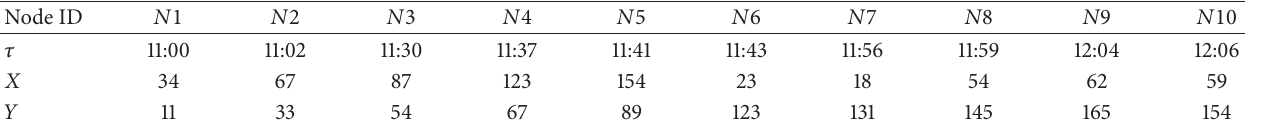
Table 1: iNODEINFO table .